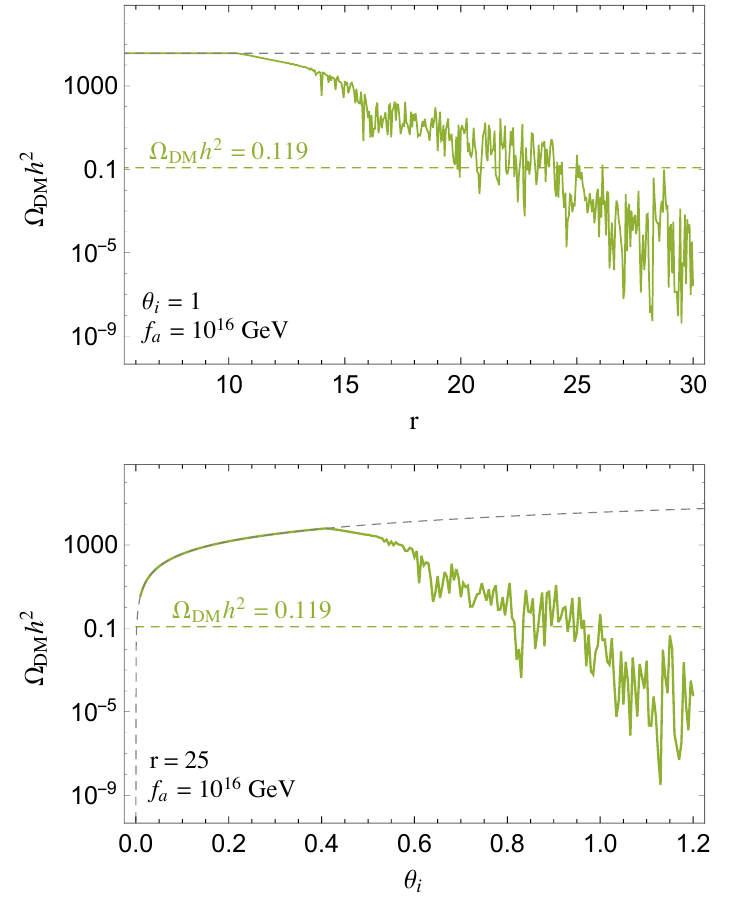
Figure 4 . The sensitivity of the axion abundance to the ratio r = f a =f d (left) and to the initial misalignment angle (cid:18) i (right). The dashed gray line is the axion abundance in the absence of